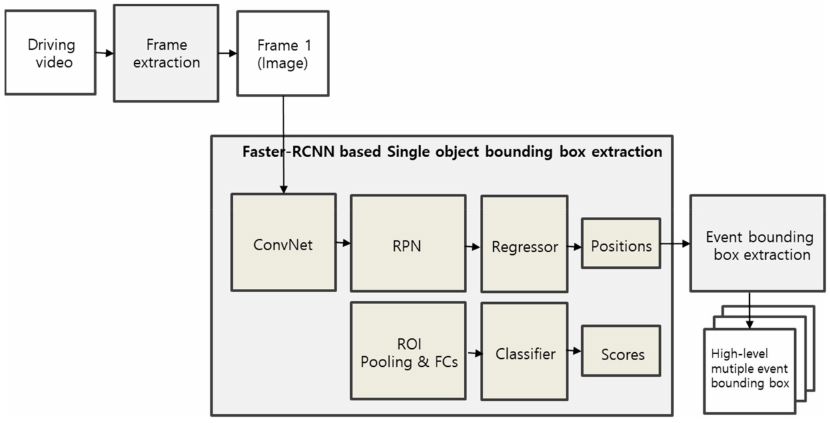
Figure 2. Multiple high-level events extraction